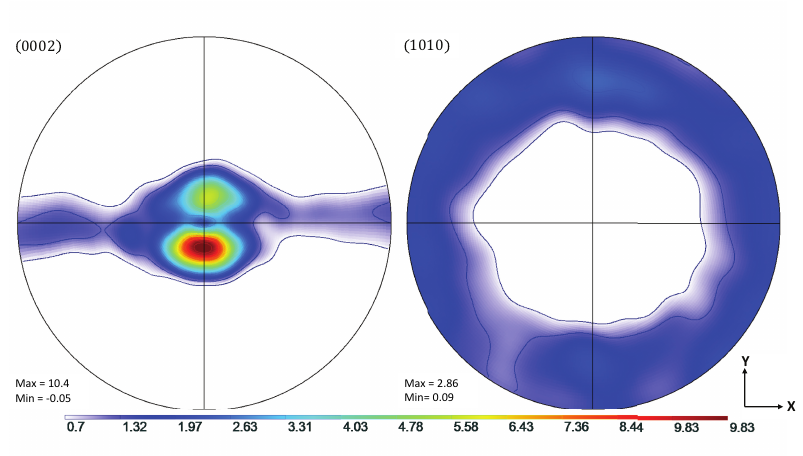
Figure 1. Pole figures showing the initial rolled texture of the Mg specimen.